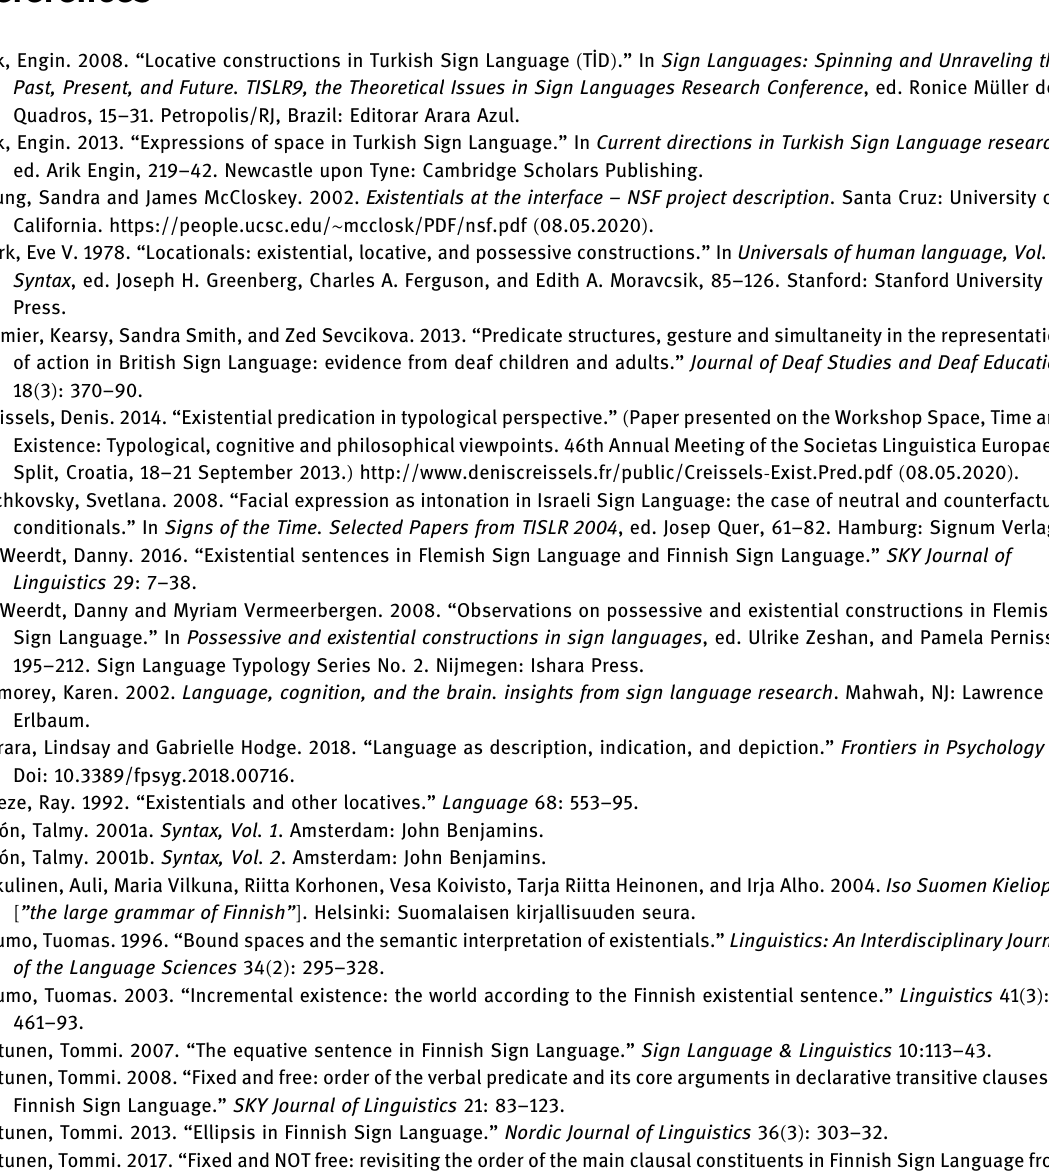
Figure – Ground Spatial Relationships in Finnish Sign Language Discourse 